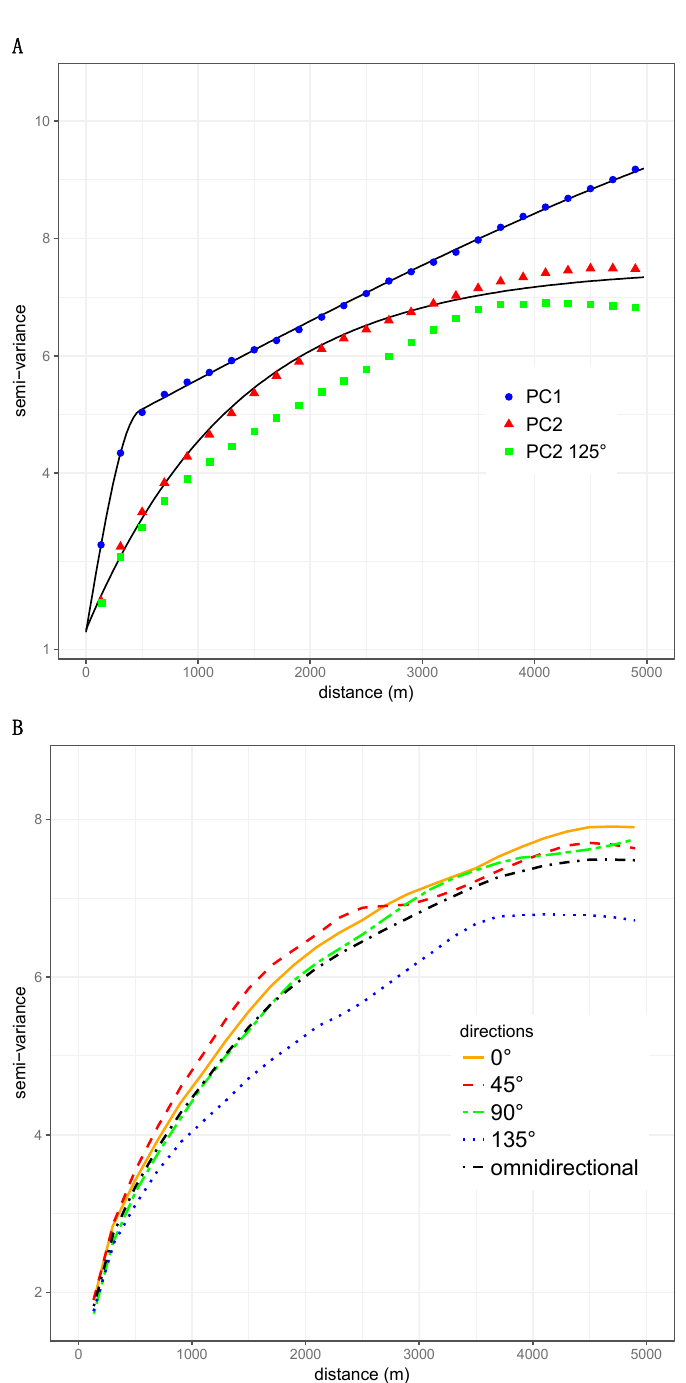
Figure 4. Structural analysis of the first two axes of the PCA of landscape metrics describing the urban structure of the city of Niamey: ( A ) omni-directional variograms of the PCA axes 1 and 2 and directional variogram for the direction of 125 ◦ of axis 2; ( B ) directional (0 ◦ , 45 ◦ , 90 ◦ , and 135 ◦ ) and omni-directional variograms for the axis 2 of the PCA.